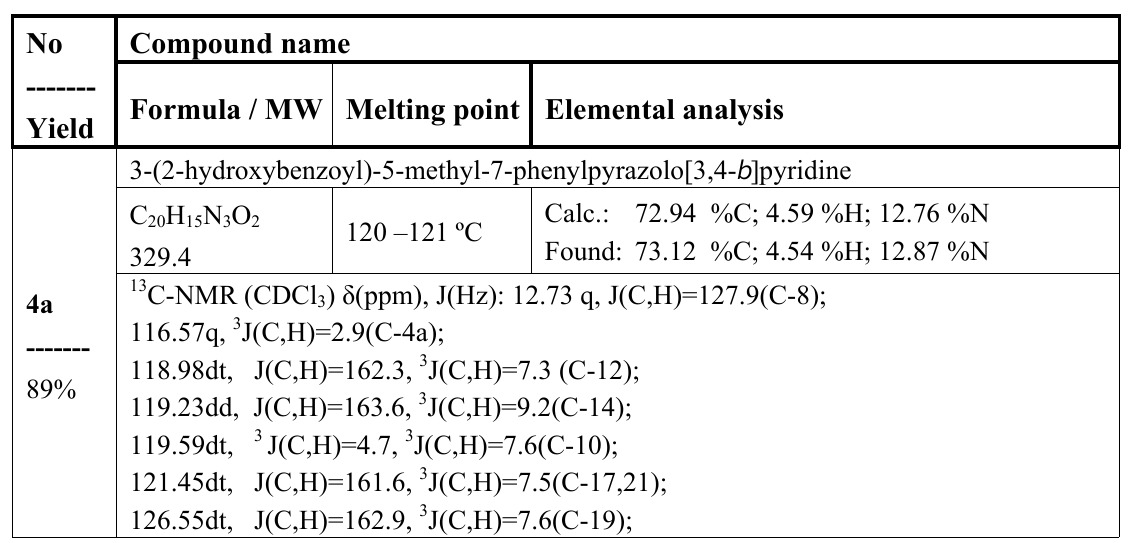
Table 1: Physical data of the compounds